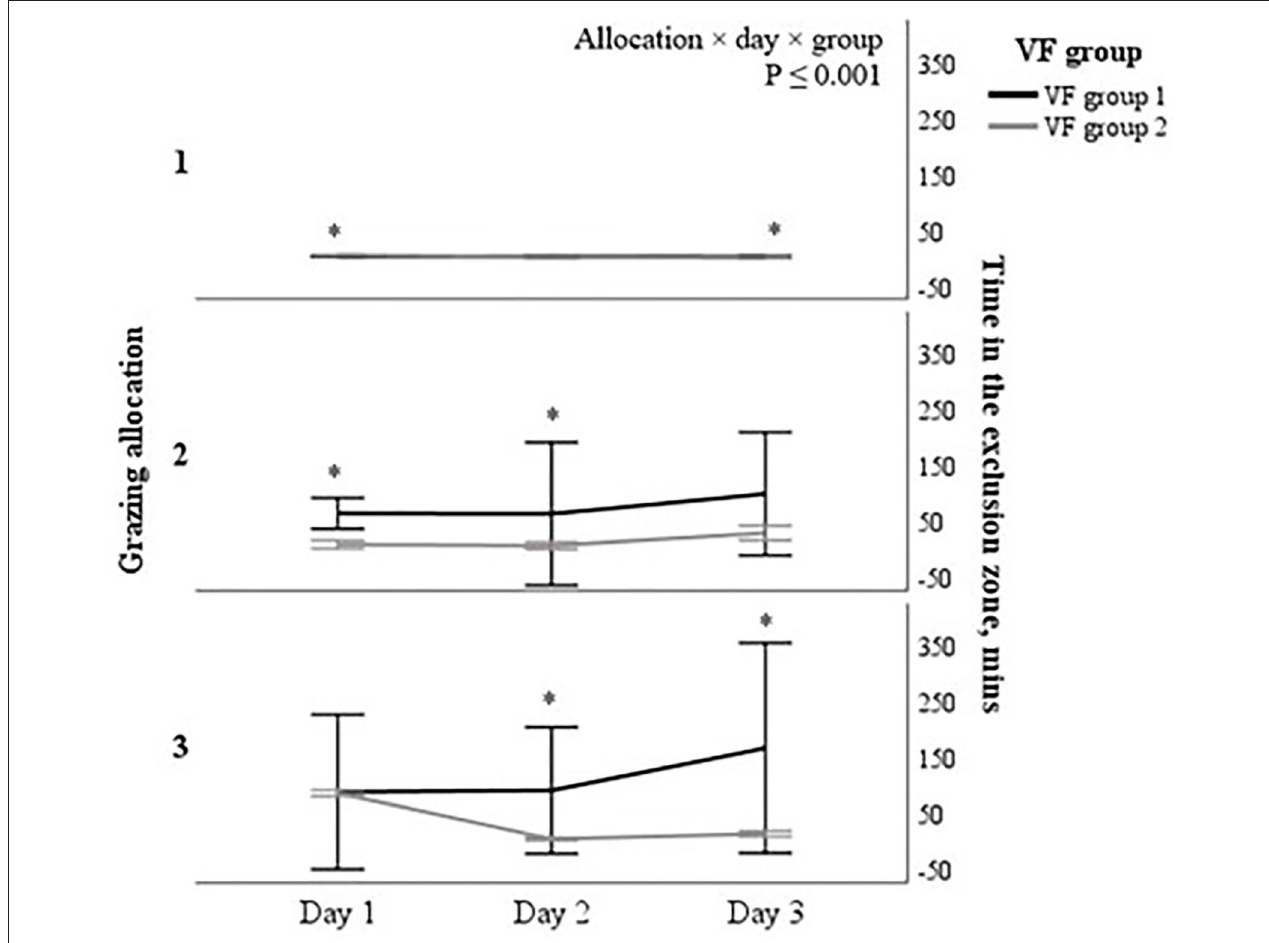
FIGURE 4 | Time heifers in VF group 1 and VF group 2 spent beyond the virtual boundary (i.e., in the exclusion zone) at each day (1, 2, or 3) of each grazing allocation (1, 2, or 3). Raw means ± 1 sd are presented. Least square means ± standard errors are presented in Supplementary Table 1 . Within days and allocations, differences between VF groups are indicated by